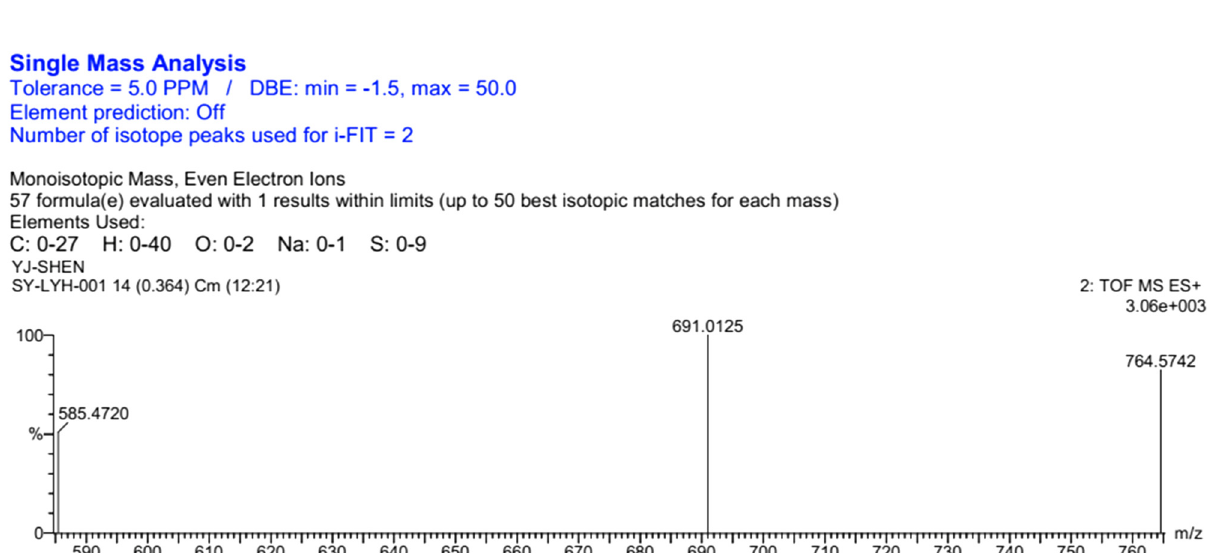
Figure A3: HRMS ( ESI ) of TTF -